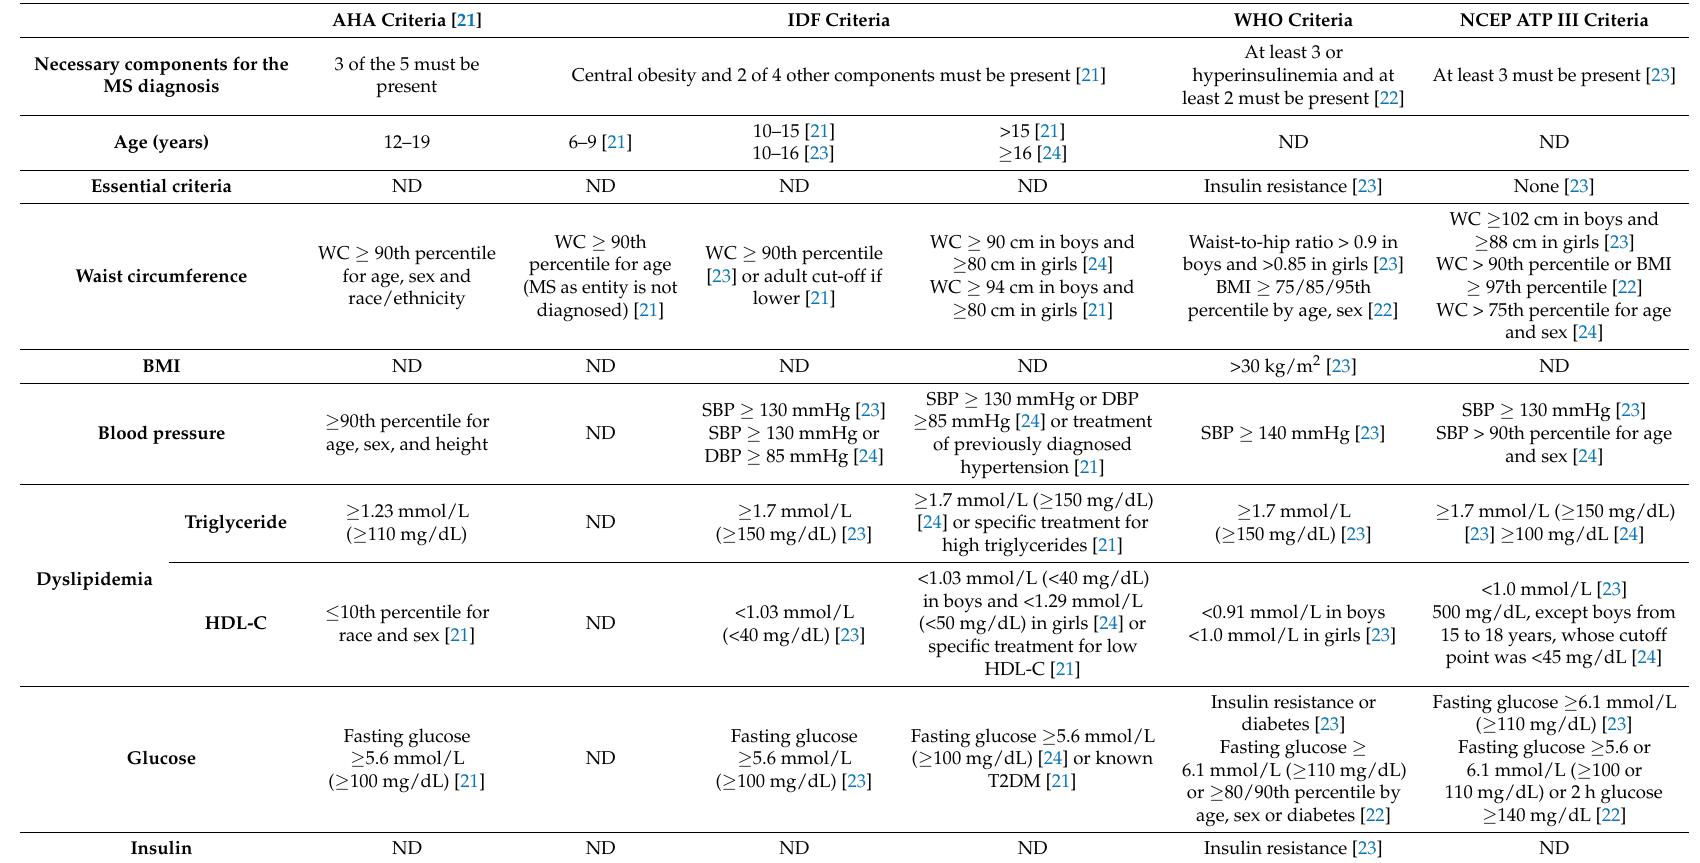
Table 1. Diagnosis of metabolic syndrome in children and